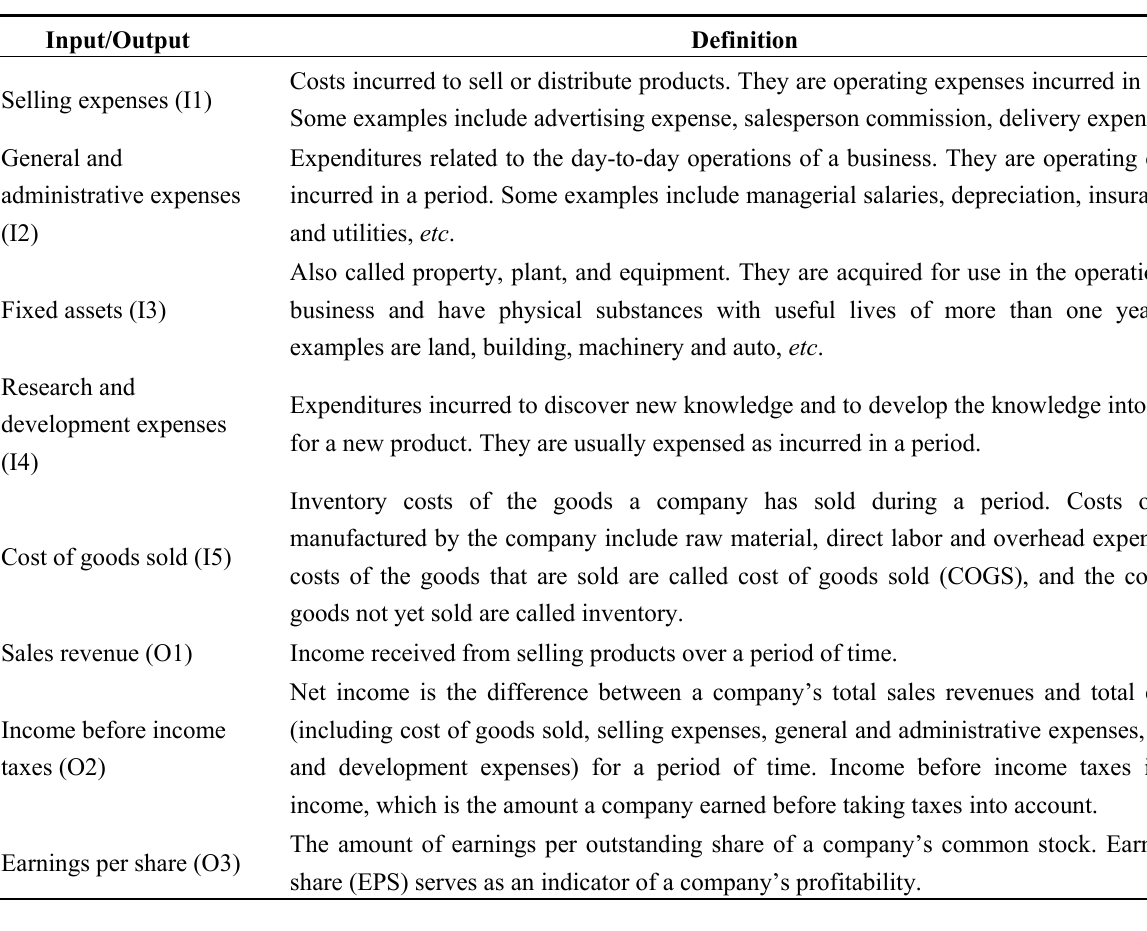
Table 2. Definitions of inputs and